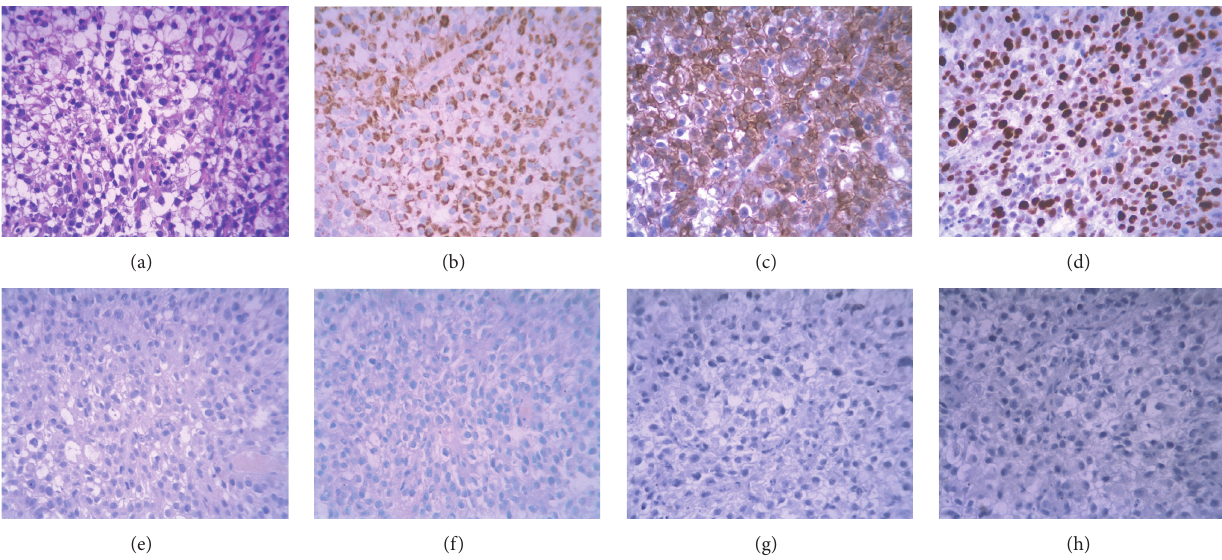
Figure 3: Histopathological staining findings. (a) H&E staining showing high nucleus/cytoplasm ratios and numerous abnormal mitotic divisions in sampled cells. (b–h) Immunohistochemical examinations revealing positive Hep Par 1 and Villin, 80% positive Ki-67, focused weak positive CK 7, and negative AFP, CK 19, and CK 20. Magnification ×